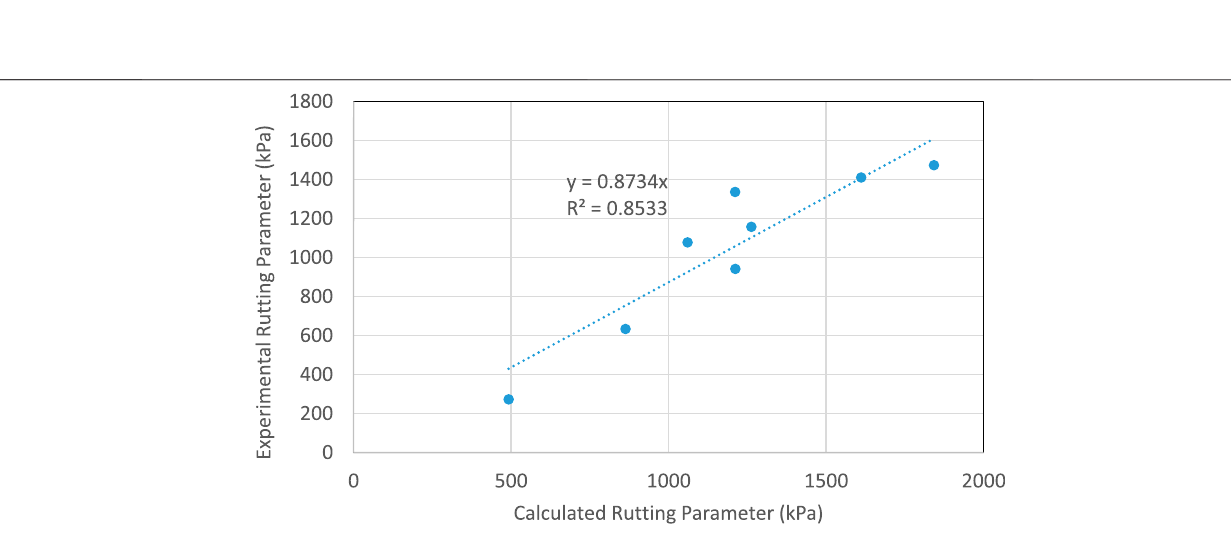
FIGURE 11 | Predicted vs. experimental rutting parameter for the aged unmodi fi ed CMAs: Testing (validation) points.